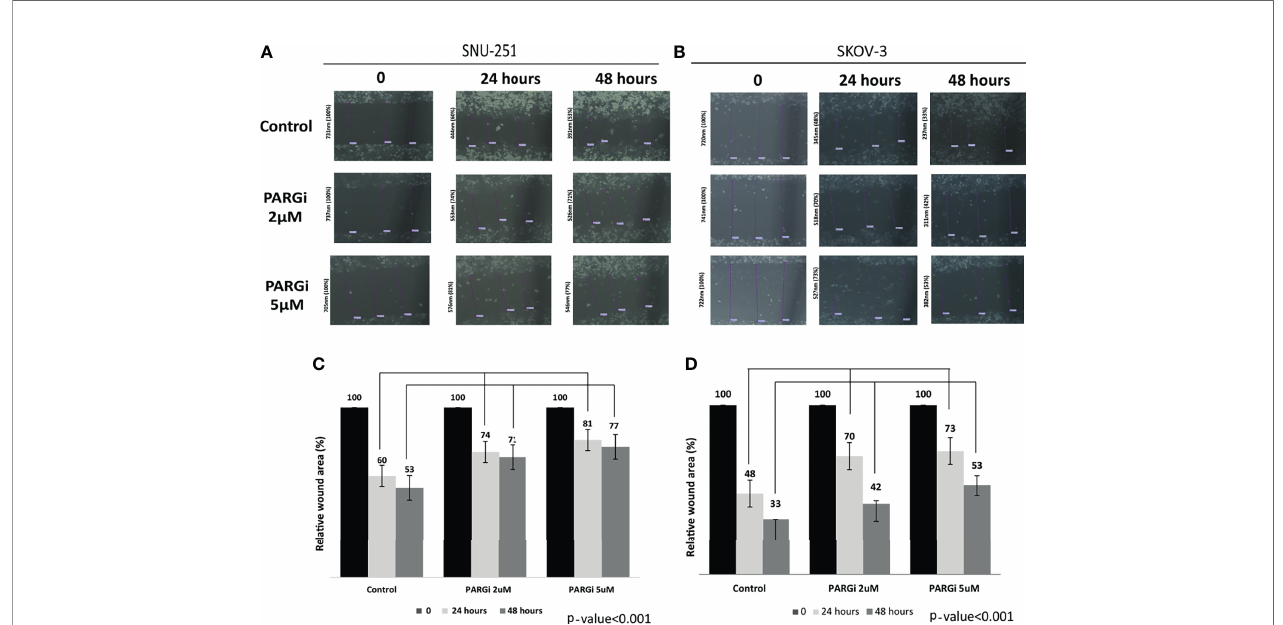
FIGURE 3 | Effect of PARG inhibitor on cell migration. ‘‘ Wounds ’’ were made on monolayers of SNU251 (A) and SKOV3 (B) cells grown to near con fl uence. Cells were then incubated in their media containing PARG inhibitor 2 and 5 m M for 24 and 48 hours. Treated or untreated (control) cells were photographed only after scratch (time 0) and after 24 and 48 hours. Results presented here are representative of triplicate independent samples of each cell line. The rate of migration was measured by quantifying the total distance that the cells (as indicated by rulers) moved from the edge of the scratch toward the center of the scratch. A value of 100% was given to the wound area at time 0. The migration of treated samples was compared with wound area at time 0. Bar graph recapitulating the percent of “ Wound ” closure that was calculated over time. P values were calculated by two-tailed t-test (C, D)